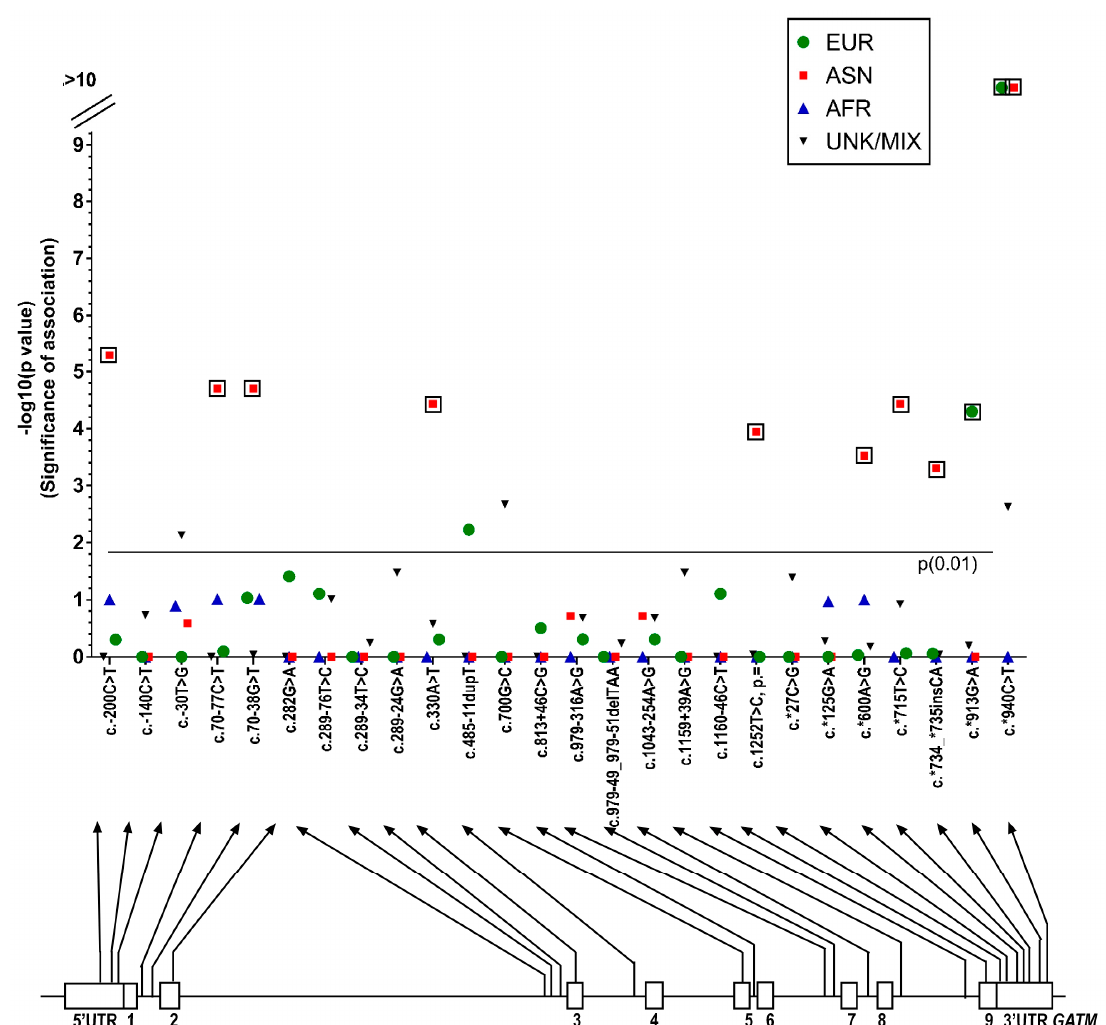
Figure 4. Manhattan plot showing the p -values from the Fisher’s exact test (significance of association, plotted as -log ( p )) for each SNP sequenced on the glycine amidinotransferase (GATM) gene. p -values are shown for European, East Asian, African, and Unknown/Admixed populations. The nominal statistical threshold for p = 0.01 is shown, and p -values that are still significant after running the Benjamin–Hochburg procedure are indicated with boxes. The location of each SNP is shown on the GATM gene below the x-axis. EUR: European; ASN: East Asian; AFR: African; and UNK/MIX: unknown/admixed populations.